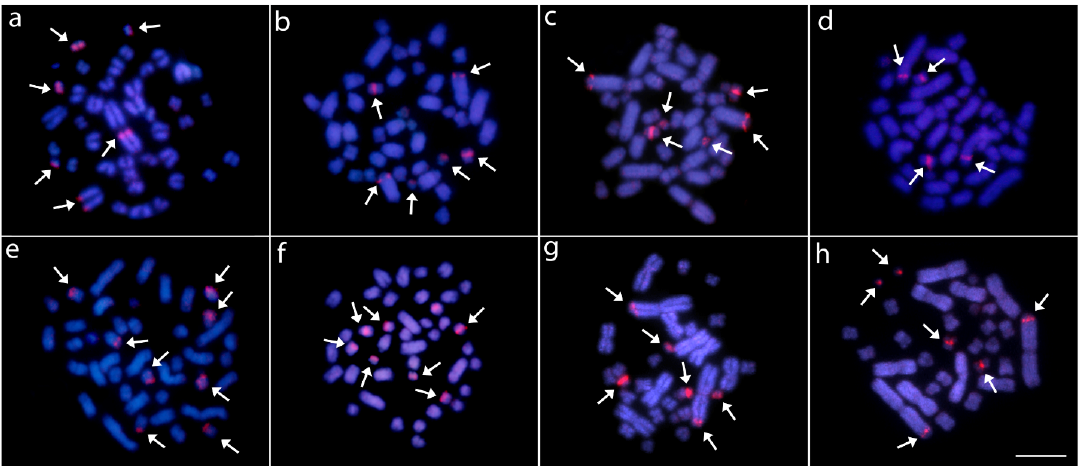
Figure 5. Metaphase chromosomes from females Caiman crocodilus ( a ), C. latirostris ( b ), C. yacare ( c ), Melanosuchus niger ( d ), Paleosuchus palpebrosus ( e ), P. trigonatus ( f ), Alligator mississippiensis ( g ), and A. sinensis ( h ) hybridized with (CGG) n microsatellite probe (red). Chromosomes were counterstained with DAPI (blue). Arrows indicate the CGG+ signals. Bar = 20 µm.